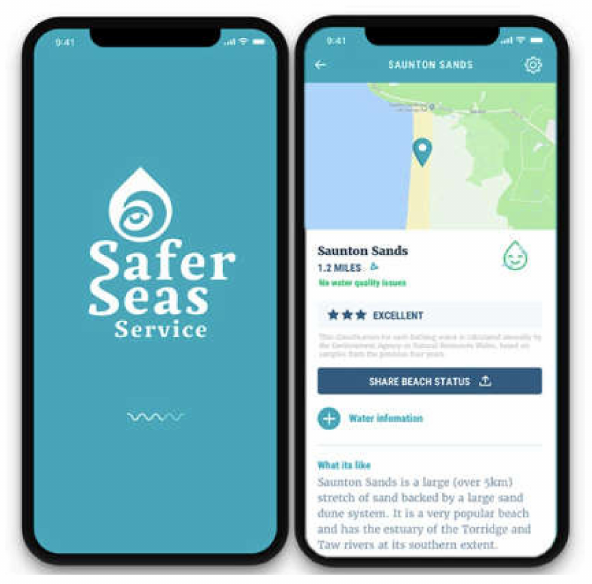
Figure 1. Screenshot of the Safer Seas Service